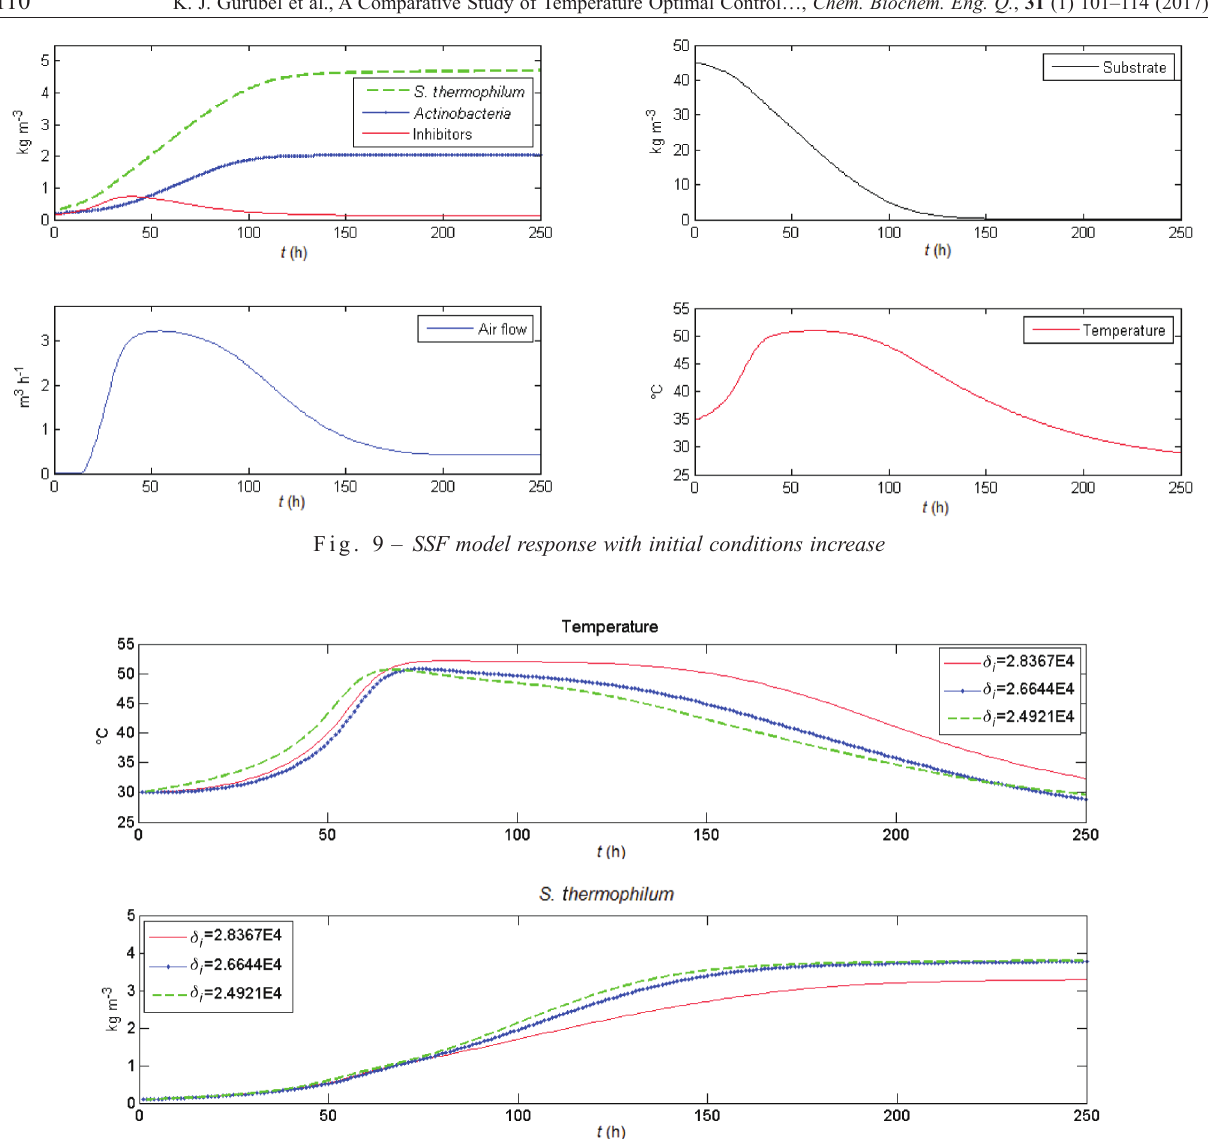
Fig. 10 – SSF model response with sensitive parameter δ